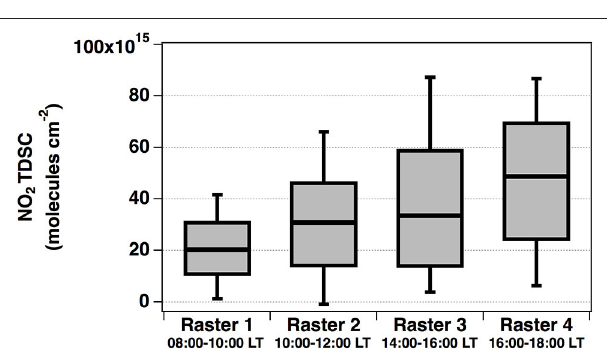
FIGURE 5 | Box plots showing the percentile distributions of NO 2 TDSCs for each raster in SMA from Figure 4 . The shaded box shows 25th − 75th percentile range with the whiskers extending to the 5th and 95th percentiles. The solid line dividing each shaded box is the median.